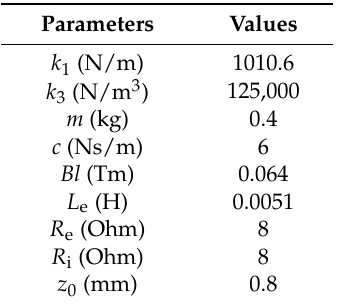
Table 2. Identified parameters of the